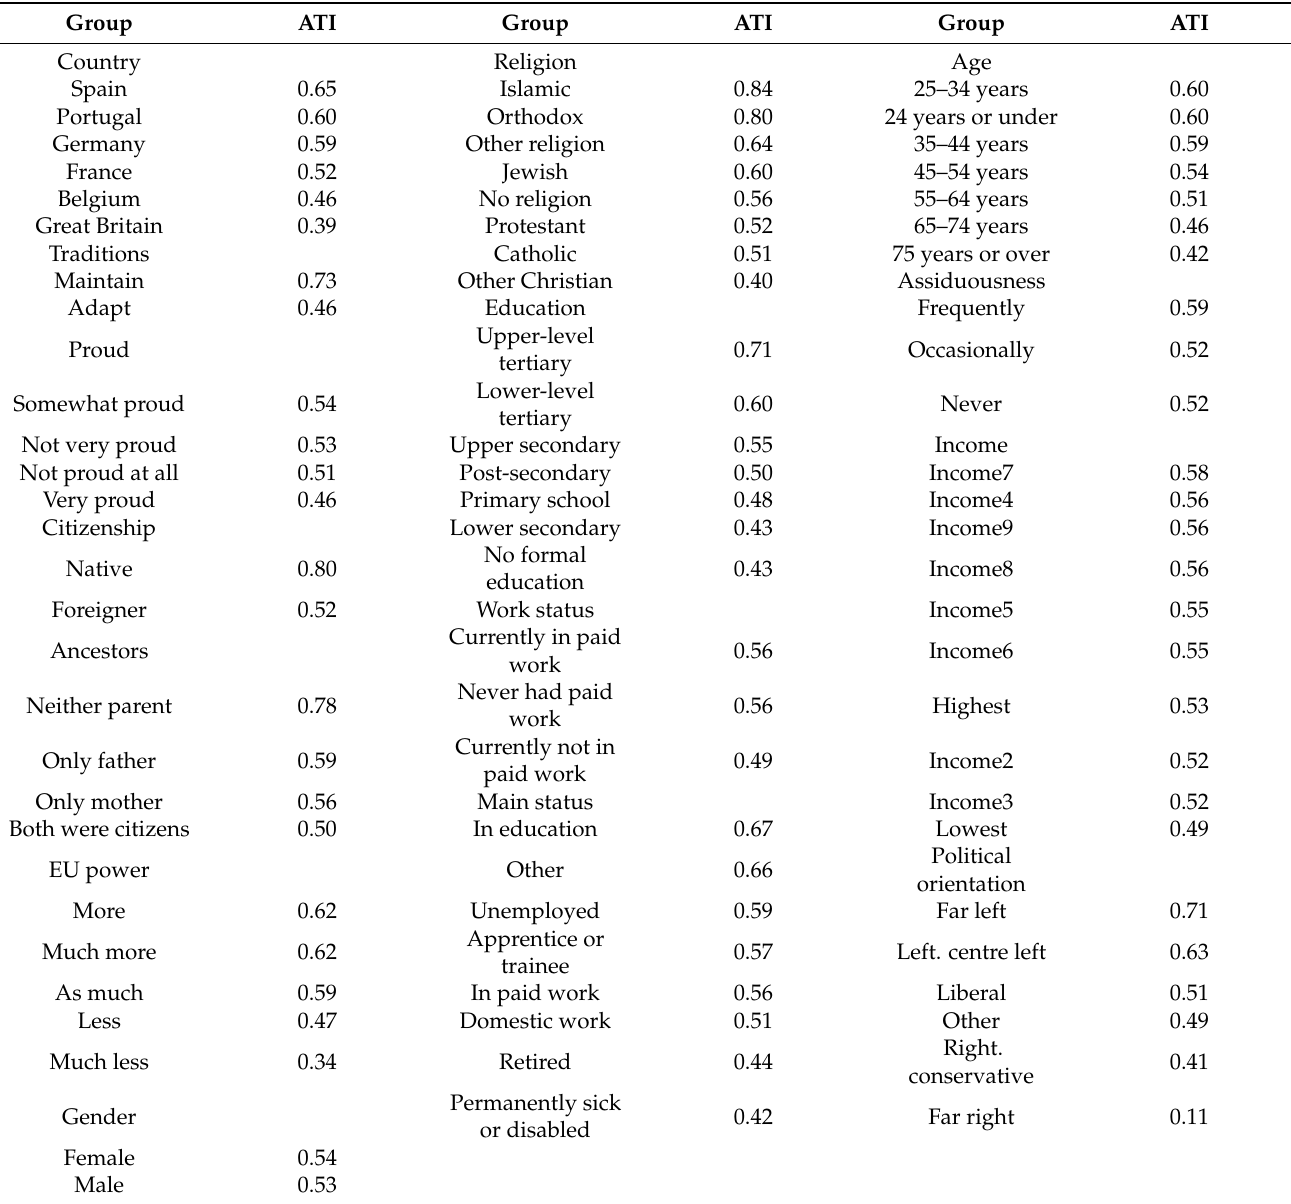
Table 3. Attitudes toward